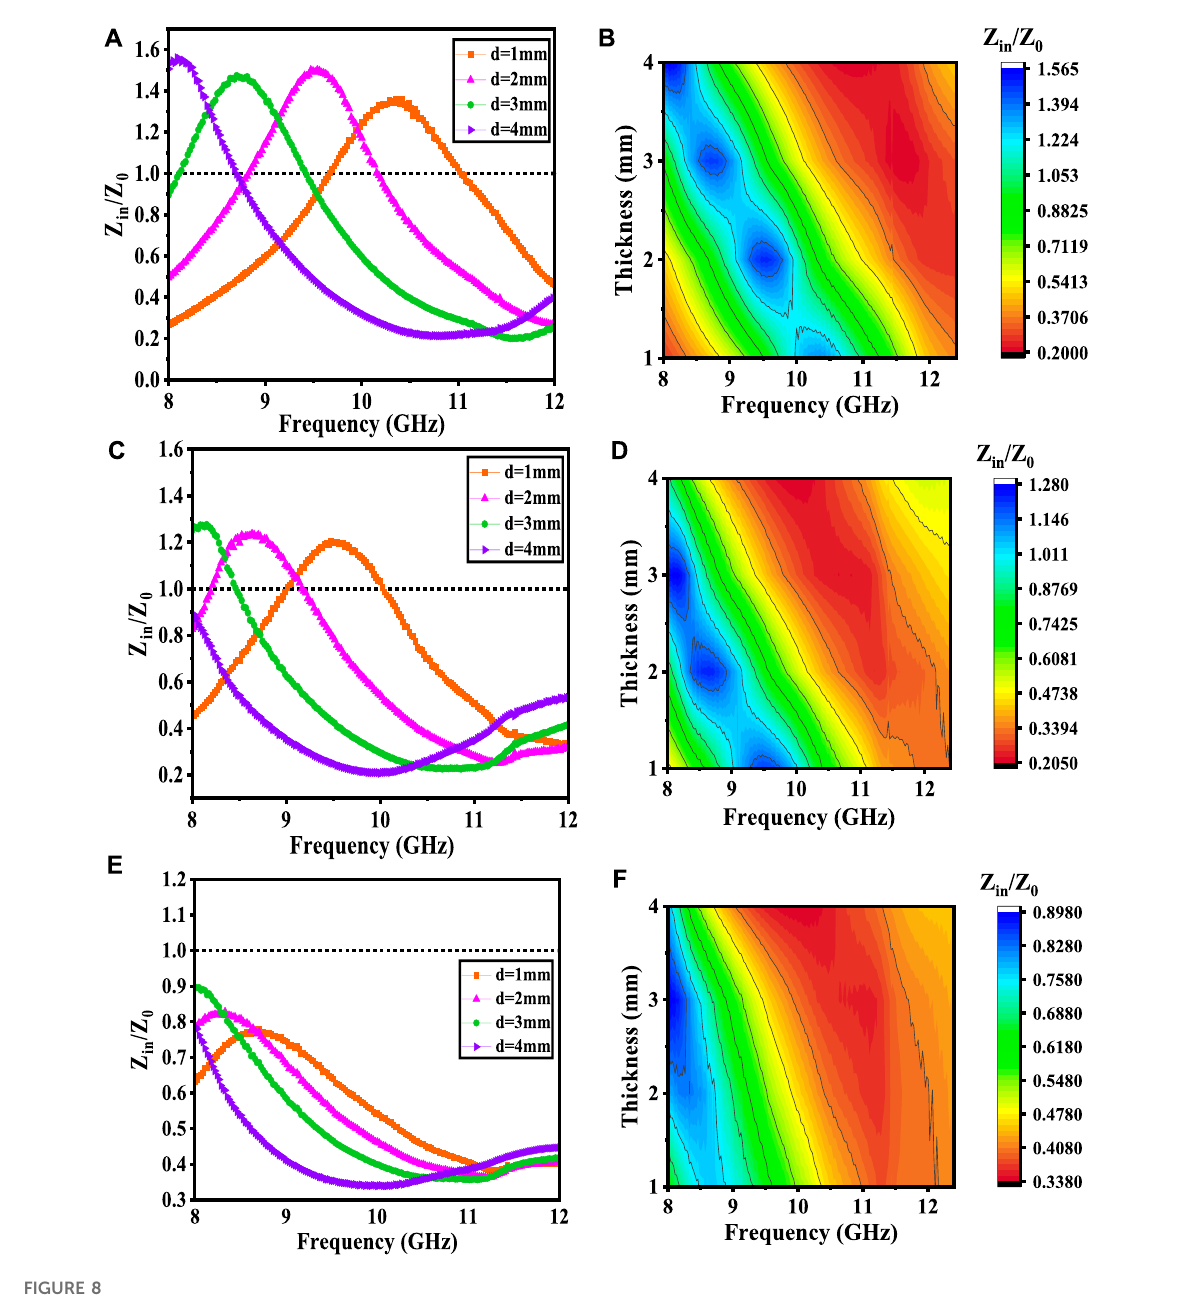
FIGURE 8 Impedance matching for Fe 3 O 4 /AC nanocomposites, two dimensional mapping plots of calculated Z in /Z 0 values of Fe 3 O 4 /AC in three differentpercentages of carbon (A, B) AC-25%, (C, D) AC-50%, and (E, F)